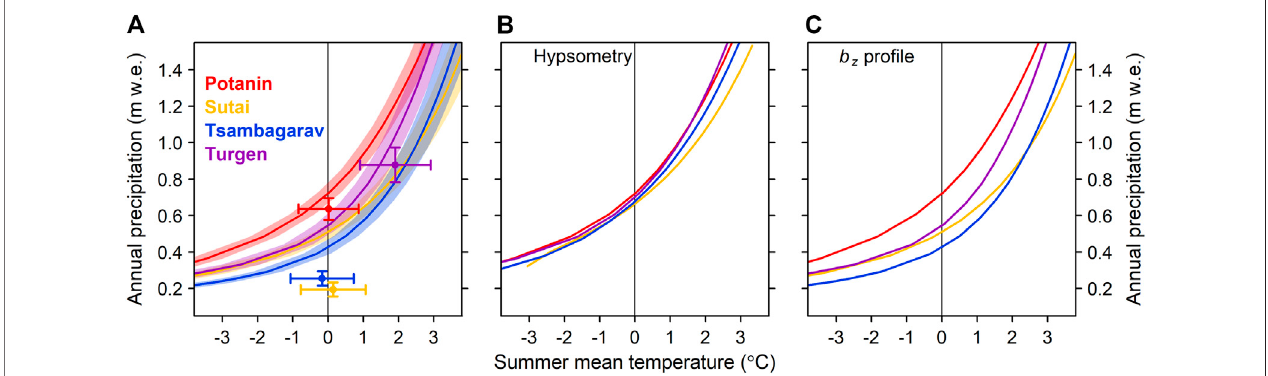
FIGURE 10 | Balanced glacier-wide mass balances for Potanin (red), Sutai (yellow), Tsambagarav (blue) and Turgen (purple) glaciers. (A) Summary of Figure 9 . Shaded regions denote the interannual variability of each zero-balance pro fi le. Each point and its associated error bars represent the long-term mean and standard deviations of the calibrated ERA5 data shown in Figure 9 , respectively. (B) Zero-balance isolines for the Potanin Glacier mass-balance pro fi le with different hypsometries. (C) Zero-balance isolines for the individual mass balance pro fi les with the Potanin Glacier